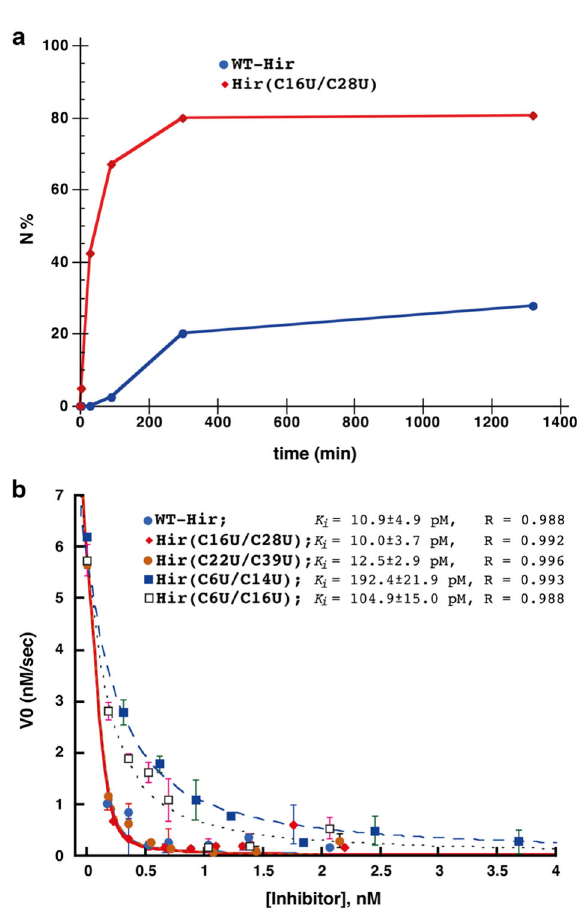
Fig. 4 Comparison between the synthetic proteins; aerobic folding and inhibition of thrombin. a Kinetic traces of the aerobic folding in the absence of GSSG and with 30 µ M WT-Hir (blue circles) or Hir(C16U/ C28U) (red diamonds) at pH 8.7. The lines connecting the data points are shown only for illustrative purposes and do not represent a data fi t. The data points are based on two repetitive experiments and the error was within 5%. b Inhibition activity of WT-Hir and Se-Hir analogues. The inhibition of bovine thrombin by WT-Hir (blue circles), Hir(C16U/C28U) (red diamonds), Hir(C22U/C39U) (brown circles), Hir(C6U/C14U) (blue fi lled squares) and Hir(C6U/C16U) (open squares). The data were fi tted as described in the Supplementary Methods 4.6 to give the apparent K I values